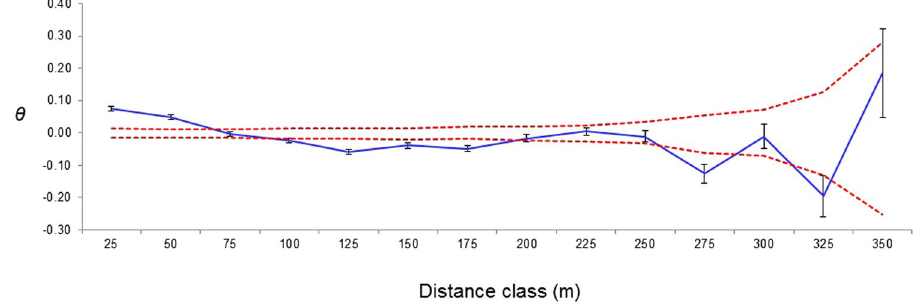
Figure 2. Correlogram of autocorrelation coefficient ( θ ; y-axis) plotted against distance (x-axis). 95% confidence intervals are indicated by dashed red lines.